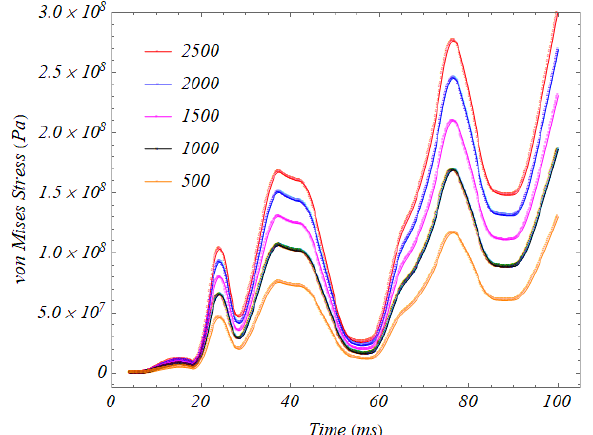
Fig. 24. von Mises stress against time for various drop distances with a single cellphone casing.